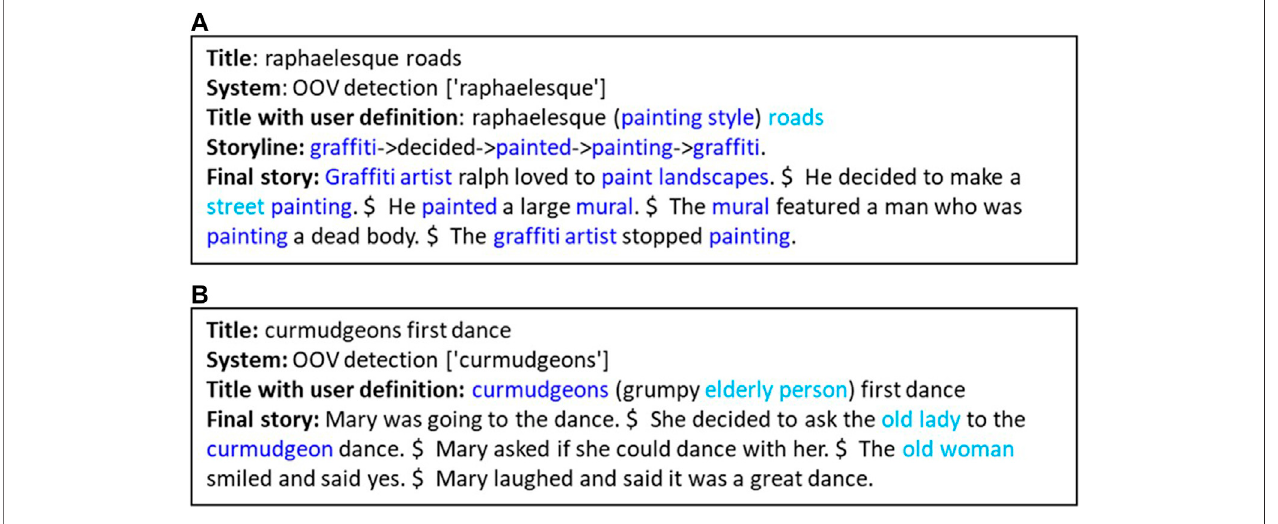
FIGURE 5 | Out-of-vocabulary (OOV) detection and management: As described in the text, these examples show a collaborative story writing system dealing with out-of-vocabulary terminology, demonstrating Hallmarks CA-4, CA-5, and CA-9. The examples were provided by the ISI human-computer collaborative storytelling system (Goldfarb-Tarrant et al., 2019; Yao et al.,